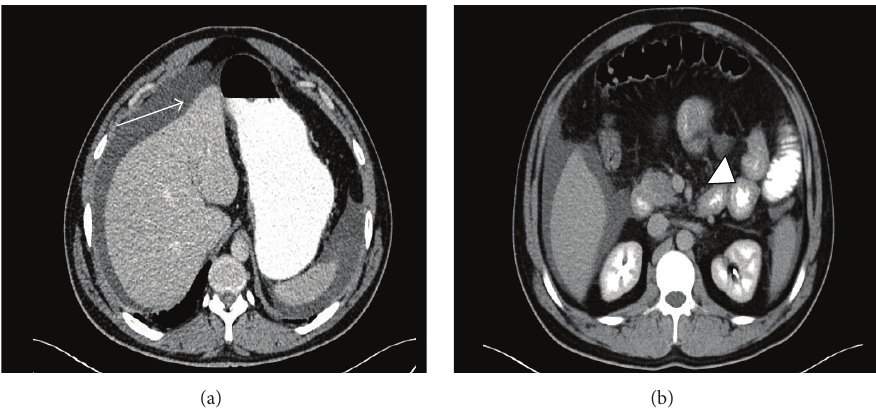
Figure 1: (a) Abdominal CT with oral and intravenous contrast demonstrated ascites in perisplenic and perihepatic area (white arrow). (b) Image study shows multiple segment of small bowel wall thickening (white arrow head).